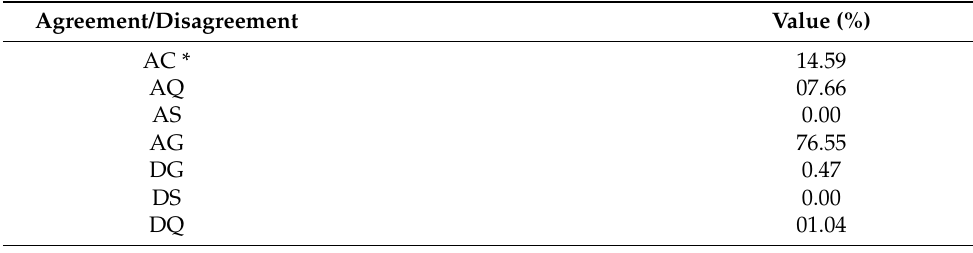
Table 13. Validation analysis of two images (agreement and disagreement components values).